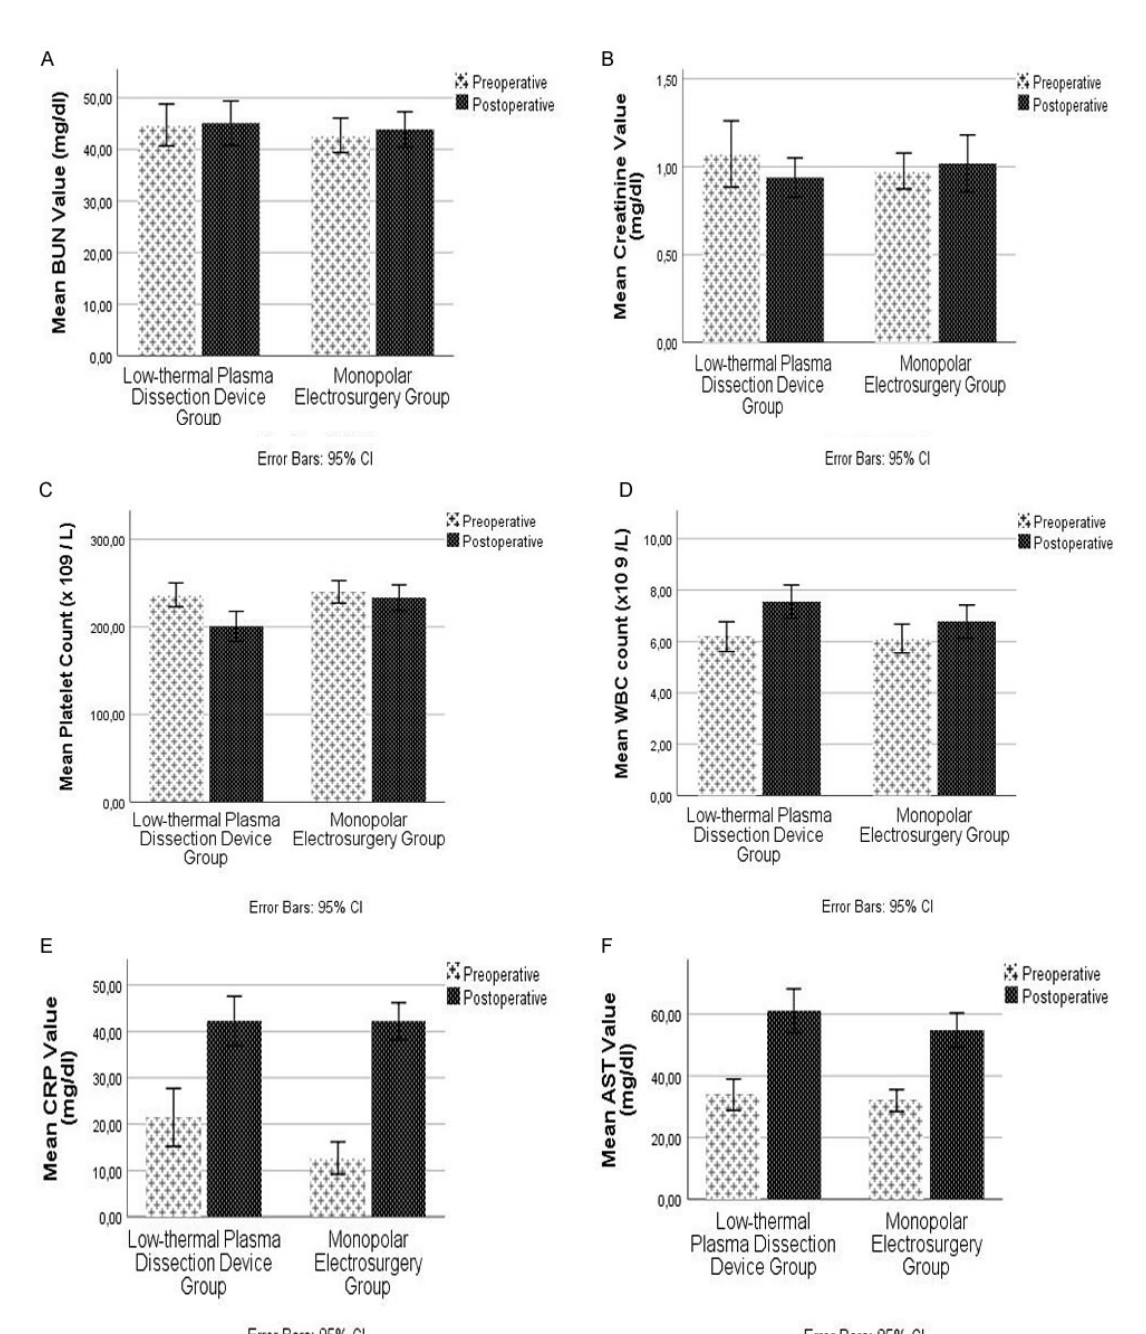
Fig. 1 - Comparison of the preoperative and postoperative hematologic and biochemical parameters between the low-thermal plasma dissection device (or plasma kinetic cautery [PKC]) group and the conventional monopolar electrosurgery (CMES) group. Statistical analysis of the differences between the groups was carried out with Mann–Whitney U test. The analyses of the preoperative and postoperative values of both groups were carried out with related-samples Wilcoxon signed-rank test. Two-sided P-value > 0.05 was considered statistically significant. A to D) Mean blood urea nitrogen (BUN) and creatinine value, and mean platelet and white blood cell (WBC) count were not found to be statistically significant in between-group analyses. Within-group analyses results are shown as related-samples Wilcoxon signed-rank test; 95% confidence interval (CI); lower, upper, P: CMES group BUN (-2, 3.5, P=0.645) and PKC group BUN (-4.5, 3, P=0.678), CMES group creatinine (0.08, 0.175, P<0.001) and PKC group creatinine (0.1, 0.17, P<0.001), CMES group platelet count (-18.5,19, P=0.98) and PKC group platelet count (-66,-26, P<0.001), and CMES group WBC (0.1, 1.15, P=0.02) and PKC group WBC (0.75, 2, P<0.001). E to F) The mean preoperative and postoperative C-reactive protein (CRP) (P=0.081 and P=0.539, respectively) and aspartate aminotransferase (AST) (P=0.960 and P=0165, respectively) values were not statistically significantly different in the between-group analyses. In within-group analyses, the postoperative values of both groups were significantly increased compared to preoperative values (CMES group CRP [26.45, 35.59, P<0.001] and PKC group CRP [13.98, 30.97, P<0.001], CMES group AST [15.28, 23.97, P<0.001] and PKC group AST [16.83, 29.51,